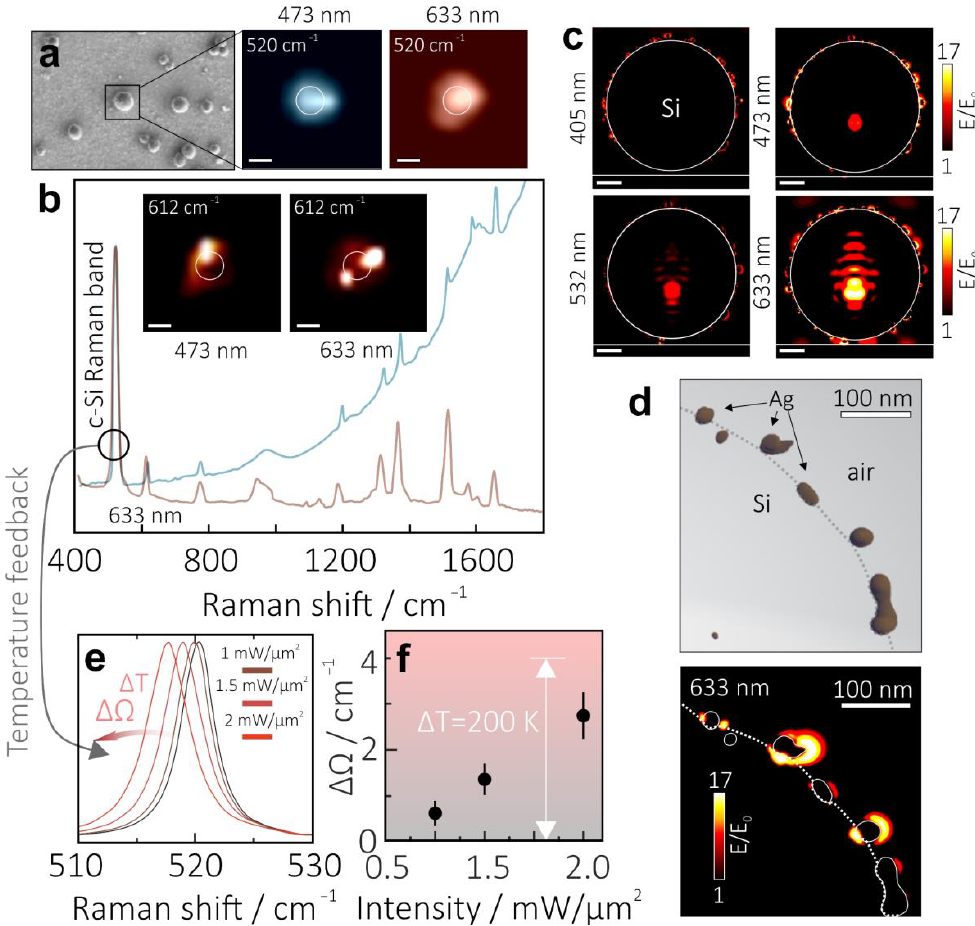
Figure 3. ( a ) Reference SEM image of the Ag-Si microspheres drop-casted onto the Si wafer as well as Raman images (at 520 ± 2 cm −1 ) of the chosen isolated nanoparticle at 473 and 633 nm laser pump wavelengths. ( b ) Representative averaged SERS spectra of the R6G capping the same Ag-Si microsphere at 473 and 633 nm laser pump wavelengths. Top insets show the distribution of the SERS signal (at 612 ± 2 cm −1 ) near the microsphere. ( c ) Normalized electric-field amplitude E/E 0 near the isolated Ag-Si microsphere on the Ag mirror upon its excitation with a linearly polarized plane wave at 405, 473, 532, and 633 nm. ( d ) Close-up distribution of E/E 0 near the isolated Ag nanoclusters on the Si surface at 633 nm pump as well as corresponding fragment of the 3D tomographic model of the Ag-Si microsphere used for modeling. ( e ) Shift of the detected c-Si Raman band at 520 cm −1 upon increasing the laser pump intensity (633 nm) of the Ag-Si microsphere from 0.5 to 2 mW/µm 2 . ( f ) Thermally induced shift of the c- Si band ΔΩ as a function of laser pump intensity.